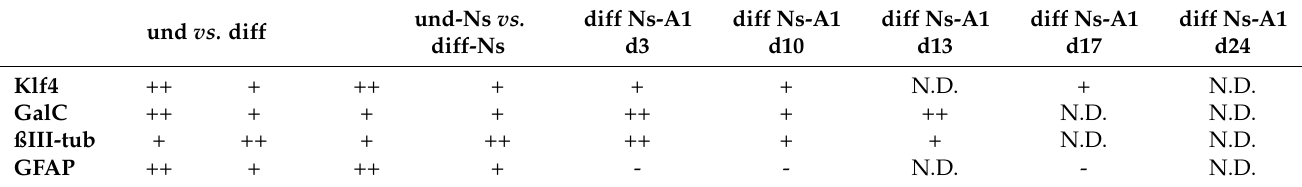
Table 1. Summary of gene expression of staminal and neural markers analyzed by real-time PCR in A1 cells cultured in different condition. The table compares undifferentiated (und) and differentiated (diff) A1 cells, neurospheres derived from undifferentiated (und-Ns) and differentiated A1 cells (diff-Ns). Neurosphere-derived A1 (Ns-A1) cells were differentiated as described in Figure 3A at different days of differentiation. Genes highly expressed are denoted with ++, while those with medium positive expression with +, and no detectable expression are denoted with -, N.D. is used for the analysis not